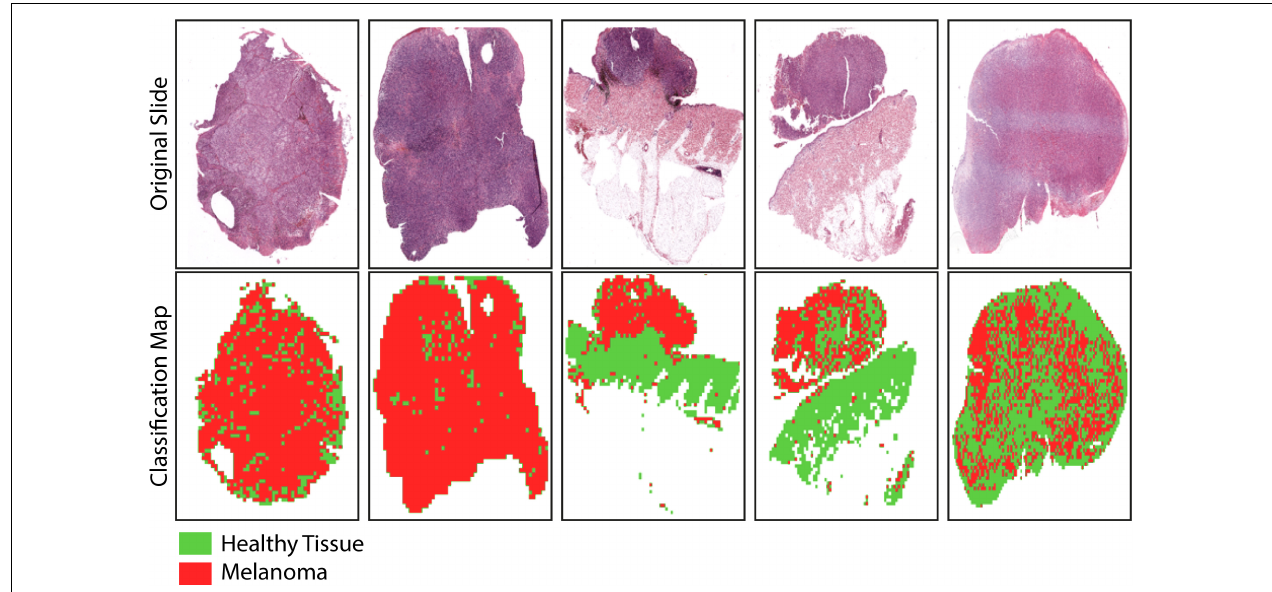
FIGURE 7 | Sample images showing the results of the trained-CNN application to five WSIs. Each WSI was associated with a classification binary map with texels representing classified patches: green area for non-melanoma patches and red area for melanoma patches. The background areas (corresponding to patches with more than 50% of the white background) were represented by the white